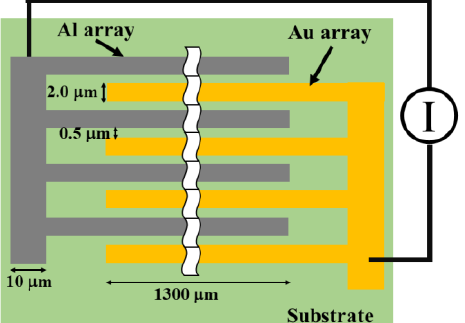
Figure 1. A schematic illustration for the MSC surface and its measurement module.